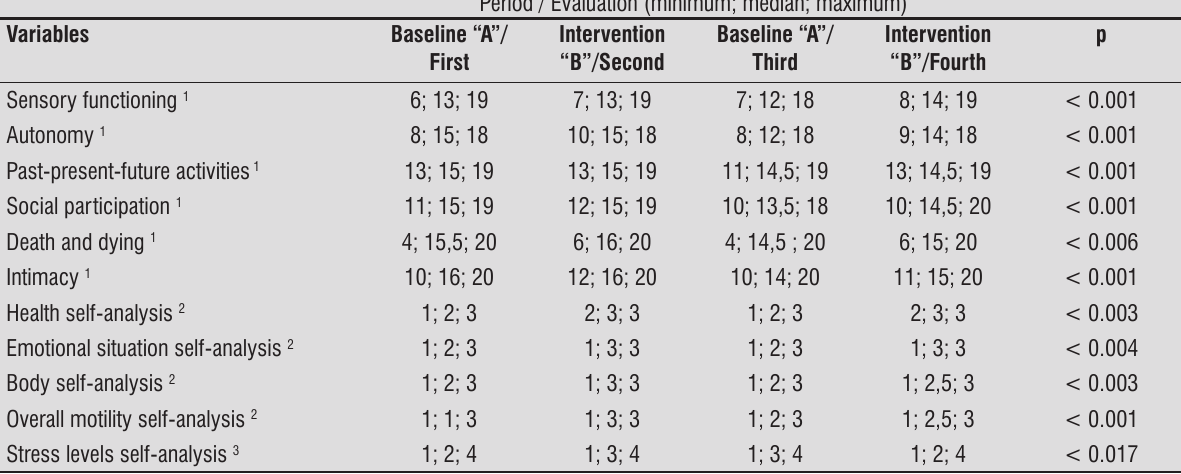
Table 4 - Comparison of the quality of life domains by the WHOQOL-OLD and self quality of life-analysis of subjects after intervention and baseline periods (n = 24).